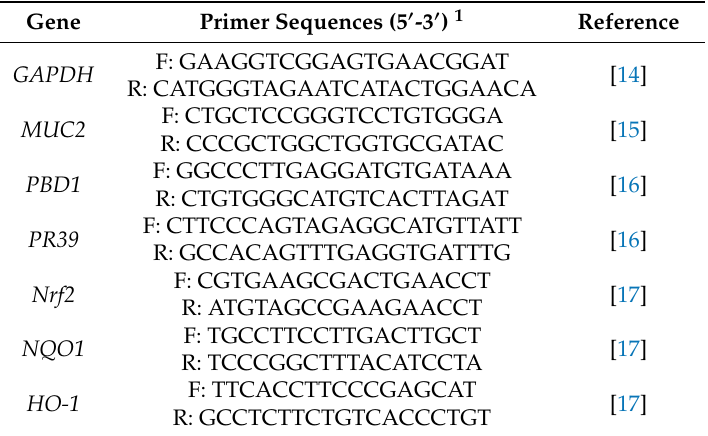
Table 2. List of primers used in this study. Gene Primer Sequences (5 (cid:48) -3 (cid:48) ) 1